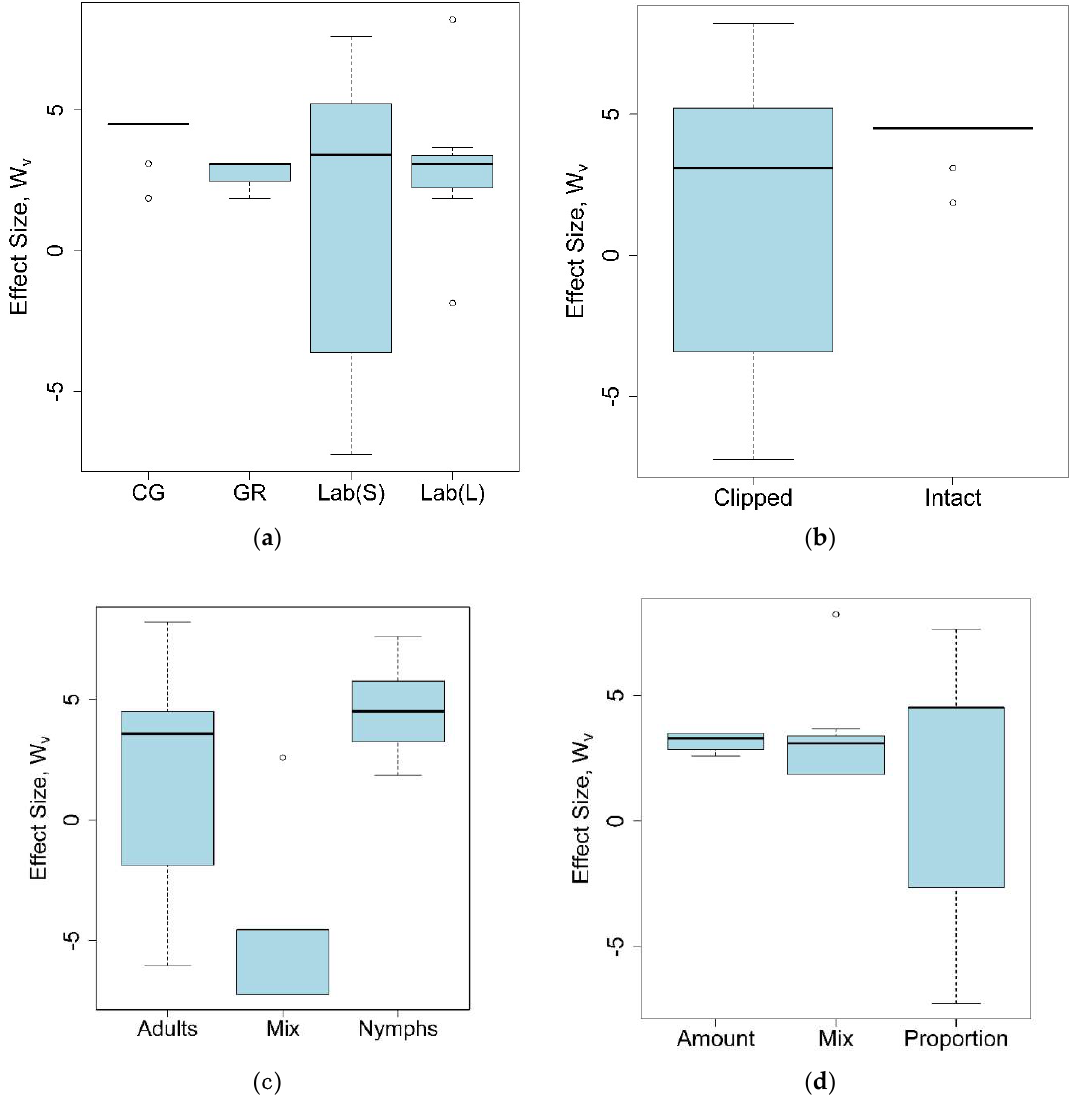
Figure 4. Mean effect sizes (with 95% confidence intervals) for studies conducting different feeding trials: ( a ) Studies used different experimental environments (CG: Common garden; GR: Greenhouse; Lab(S): Laboratory, clipped stems; Lab(L): Laboratory, clipped leaves); ( b ) studies used different plant material; ( c ) studies used different grasshopper life stages; ( d ) studies used different types of measurements (amount: Amount of plant tissue consumed by grasshoppers; proportion: Proportion of plant damage caused by grasshoppers). Outcomes and 95% confidence intervals for 55 studies included in the meta-analysis, as well as sample sizes, are provided in the supplementary material (Tables S4 and S5).